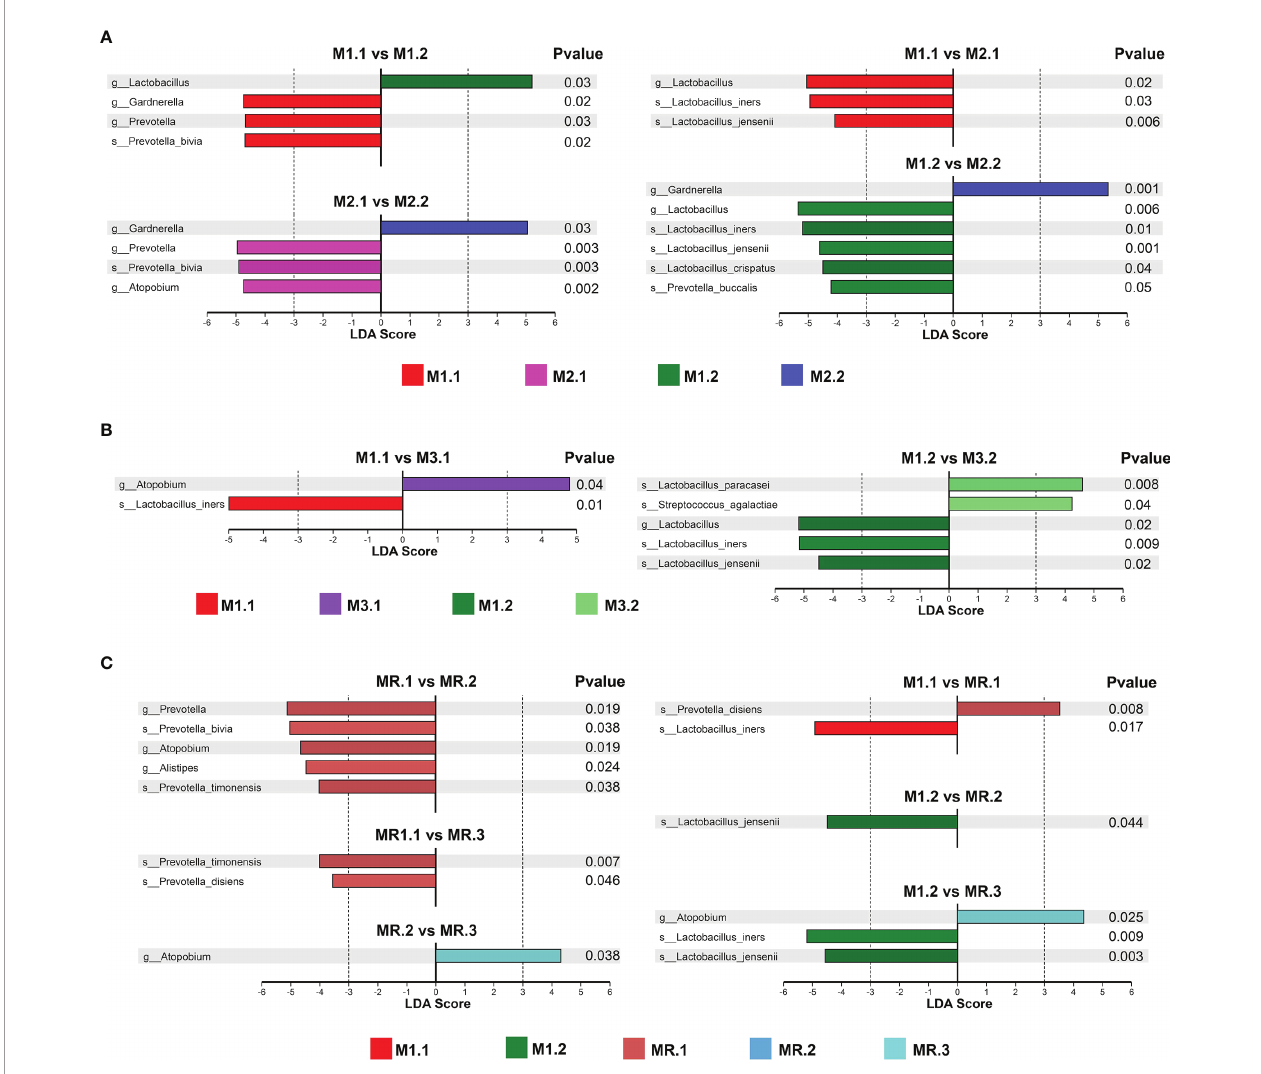
FIGURE 3 | Key vaginal microorganism changes before and after treatment. LDA and T-test identi fi ed the most differentially abundant taxons between (A) patients completely cured (M1.1, M1.2) and patients with cured VVC plus uncured BV (M2.1, M2.2), (B) patients completely cured(M1.1, M1.2) and patients with cured BV plus uncured VVC (M3.1, M3.2), (C) patients completely cured (M1.1, M1.2) and patients with recurrence (MR.1, MR.2,